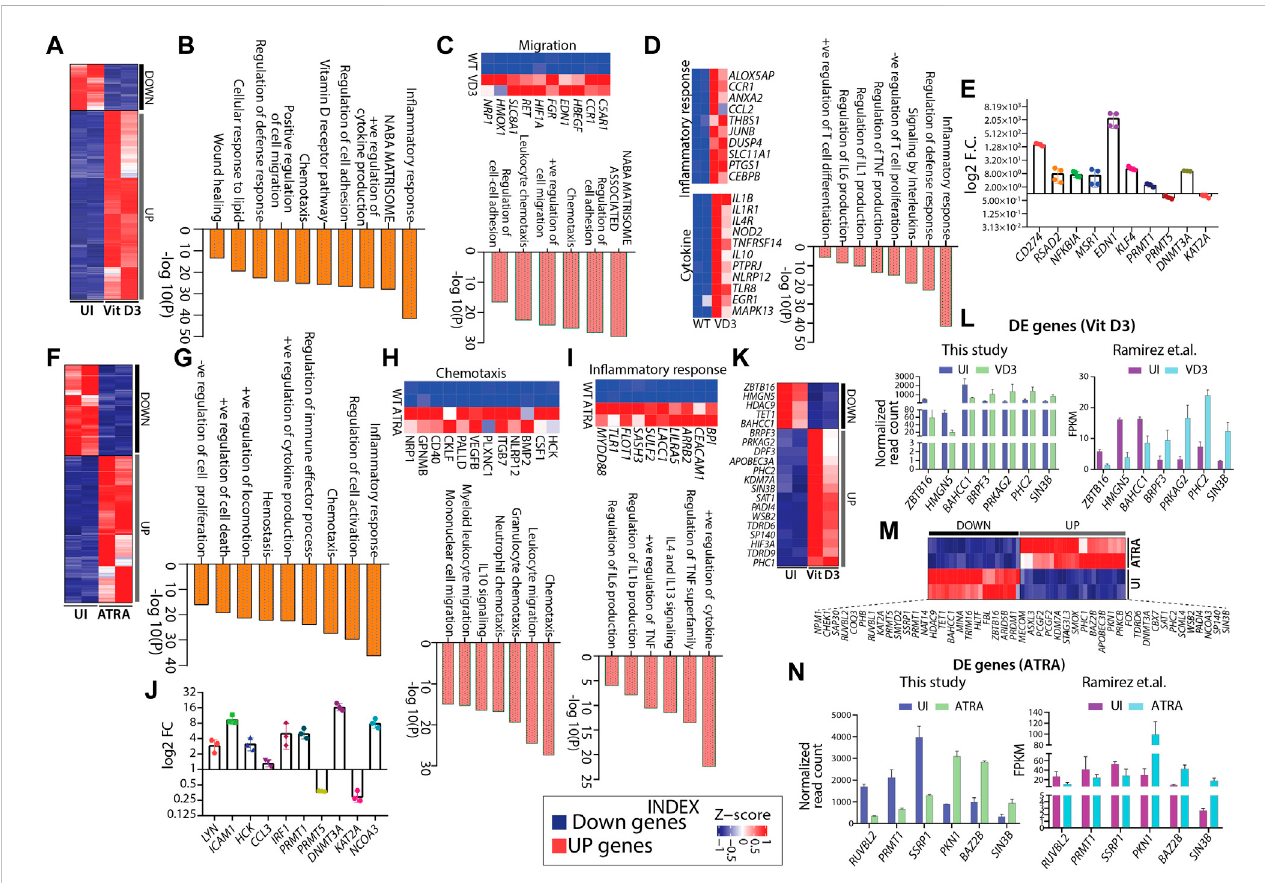
FIGURE 3 Gene expression changes in HL60 during myeloid differentiation. (A) Heatmap showing gene expression changes with Vit D3 induction for 72 h in HL60 cells. (B) Bar graph showing signi fi cance (-log10 as the p -value) for each pathway enriched from the upregulated genes obtained from Vit D3 induction compared with uninduced HL60 cells. (C – D) Heatmap and biological pathways (signi fi cance -log10 as the p -value) are associated with cell migration, in fl ammatory response, and cytokine response from the set of genes induced during Vit D3 induction. (E) RT - qPCR validation of the selected pathways like an in fl ammatory response ( RSAD2 , NFKBIA ), cytokine response ( MSR1, EDN1 ), cytoskeleton regulation ( CD274 , KLF4 ) and epigenetic factors ( PRMT1, PRMT5, DNMT3A,KAT2A )intheVitD3monocytes comparedto theuninducedHL60 cells. (F) Heatmapsimilartopanel A,except differentialgene expression isfrom72 hpost-ATRAinduction. (G) Bargraphshowingthepathways(signi fi cance-log10asthe p -value)enrichedfromupregulatedgenesobtainedinATRA induction. (H – I) Heatmap and biological pathways associated with chemotaxis and in fl ammatory response from upregulated gene sets in ATRA induced HL60 cells (J) RT-qPCR validation of genes involved in regulating selected biological pathways such as in fl ammatory response and cytokine response ( IRF1, CCL3, HCK ), cell migration ( ICAM1, LYN ), and epigenetic factors ( PRMT1, PRMT5, DNMT3A, KAT2A, NCOA3 ) in ATRA induced HL60 cells compared to uninduced HL60cells. Metascapeversion3.5 isusedfor all pathway analyses. (K) Heatmapshowingthegeneexpression pro fi leofthedifferentiallyexpressed epigenetic factors with Vit D3 induction for 72 h in HL60 cells. (L) Bar graphs showing the normalized read count obtained from this study ( n = 7) (left) and FPKM values obtained from the Ramirez et al. study ( n = 7) (right) for a few epigenetic factors as obtained in panel (K) (M) Similar to panel K, except the HL60 cells were induced with ATRA for 72 h. (N) Bar graphs showing the normalized read count obtained from this study ( n = 6) (left) and FPKM values obtained from the Ramirez et al. study ( n = 6) (right) for a few epigenetic factors as obtained in panel